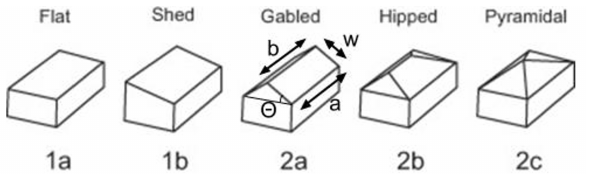
Figure 5. The common roof template library. This figure is adapted with permission from Ref. [25] by adding extra annotations. Copyright 2017,